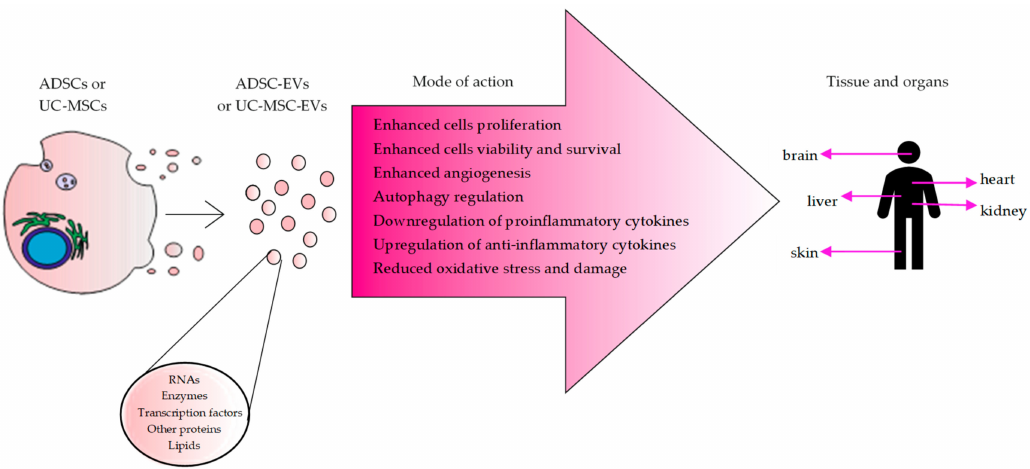
Figure 1. Extracellular vesicles mode of action in various